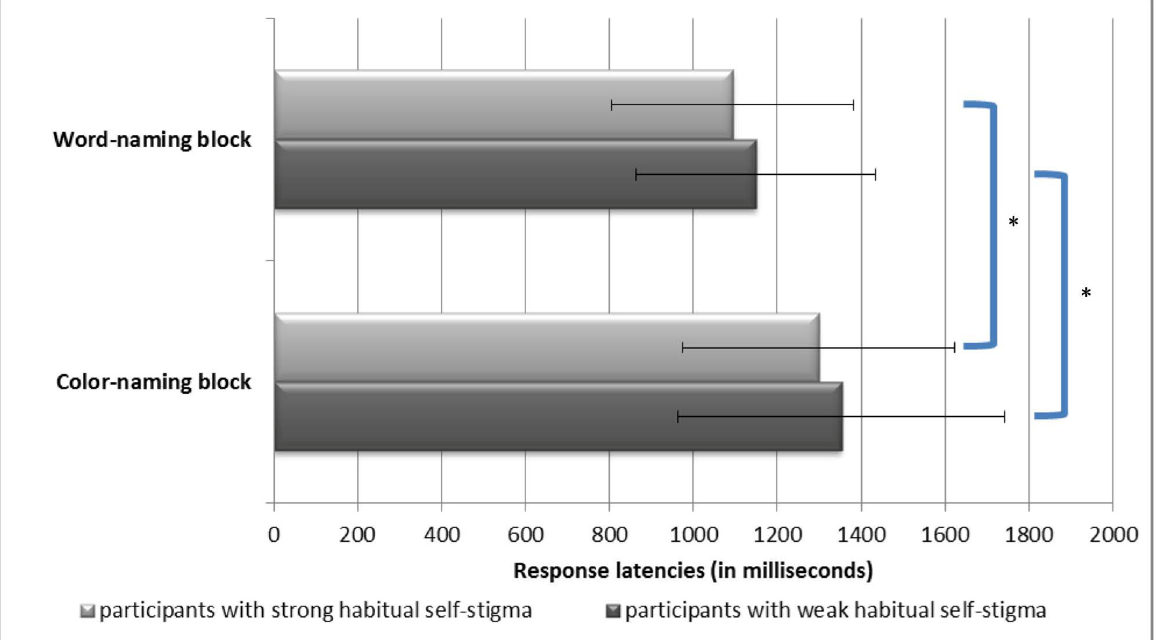
Fig 2. Participants ’ performance on the cognitive Stroop task. Mean response latencies in the word-naming and color-naming blocks. An asterisk indicates a significant